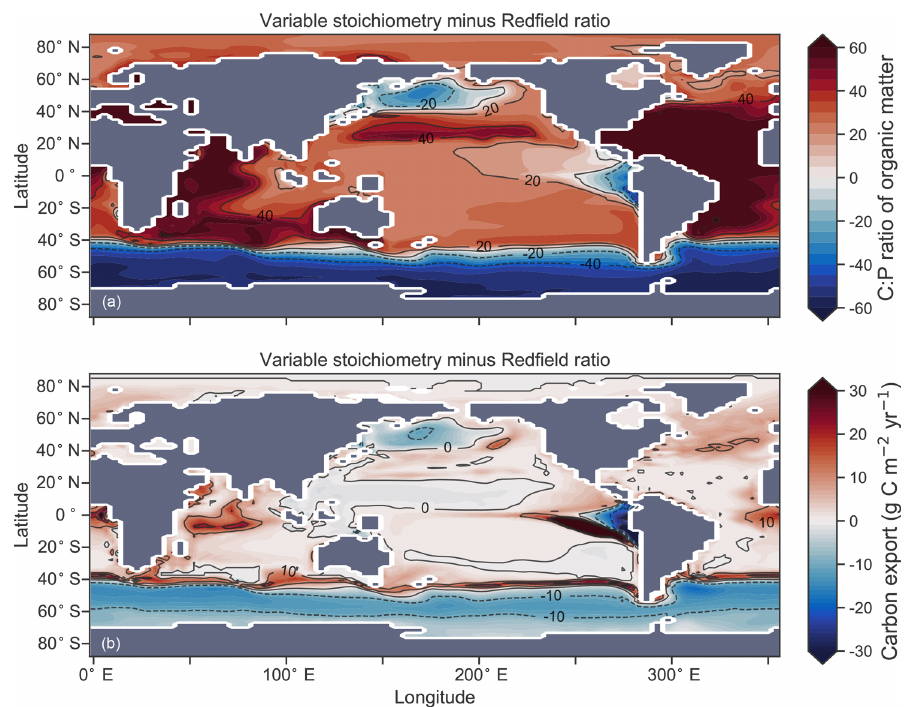
Figure 11. Simulated difference in the C : P ratio of exported organic matter due to variable stoichiometry as compared to Redfield stoi- chiometry (a) and the resulting change in carbon export out of the euphotic zone (b) .